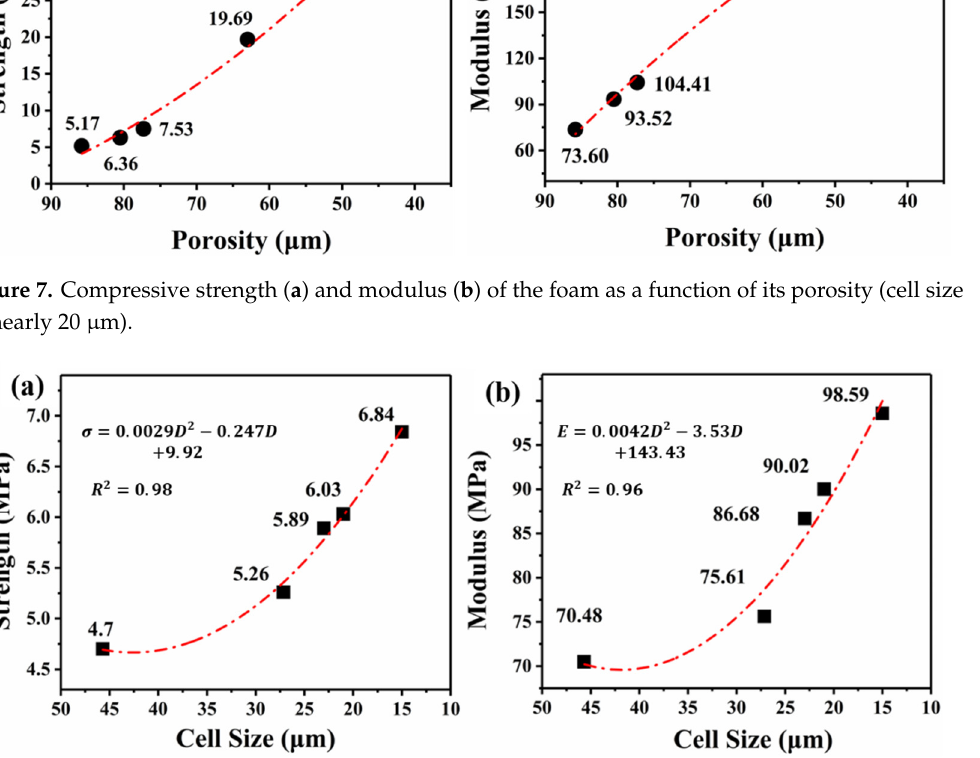
Figure 8. Compressive strength ( a ) and modulus ( b ) of the foam as a function of its cell size (porosity of nearly 82%).